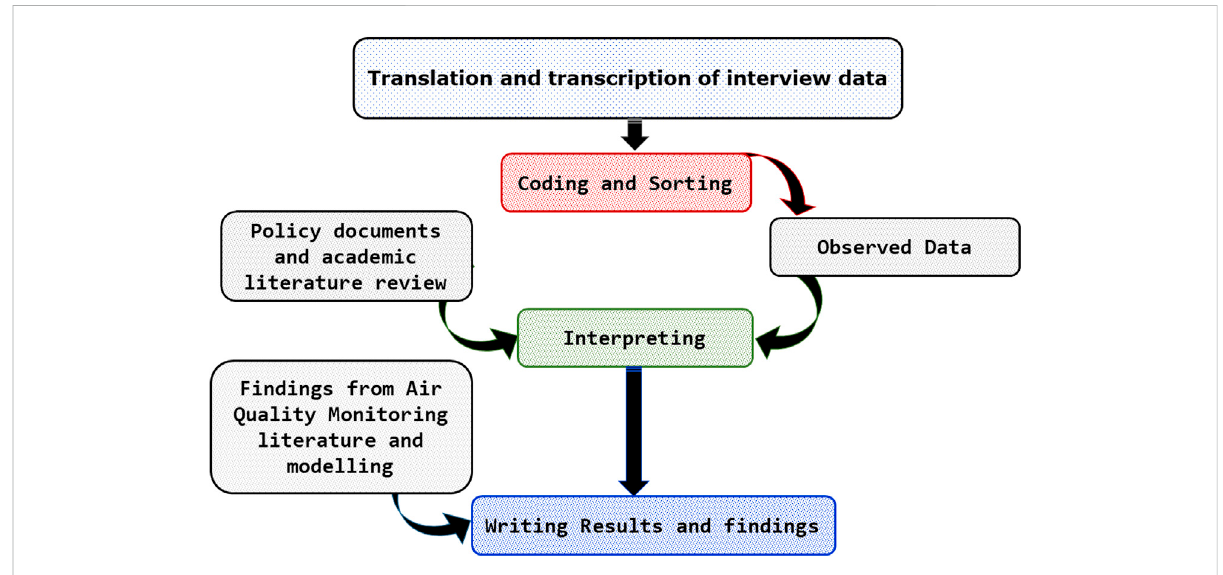
FIGURE 3 Analytical framework for the understanding of the state of air quality management in